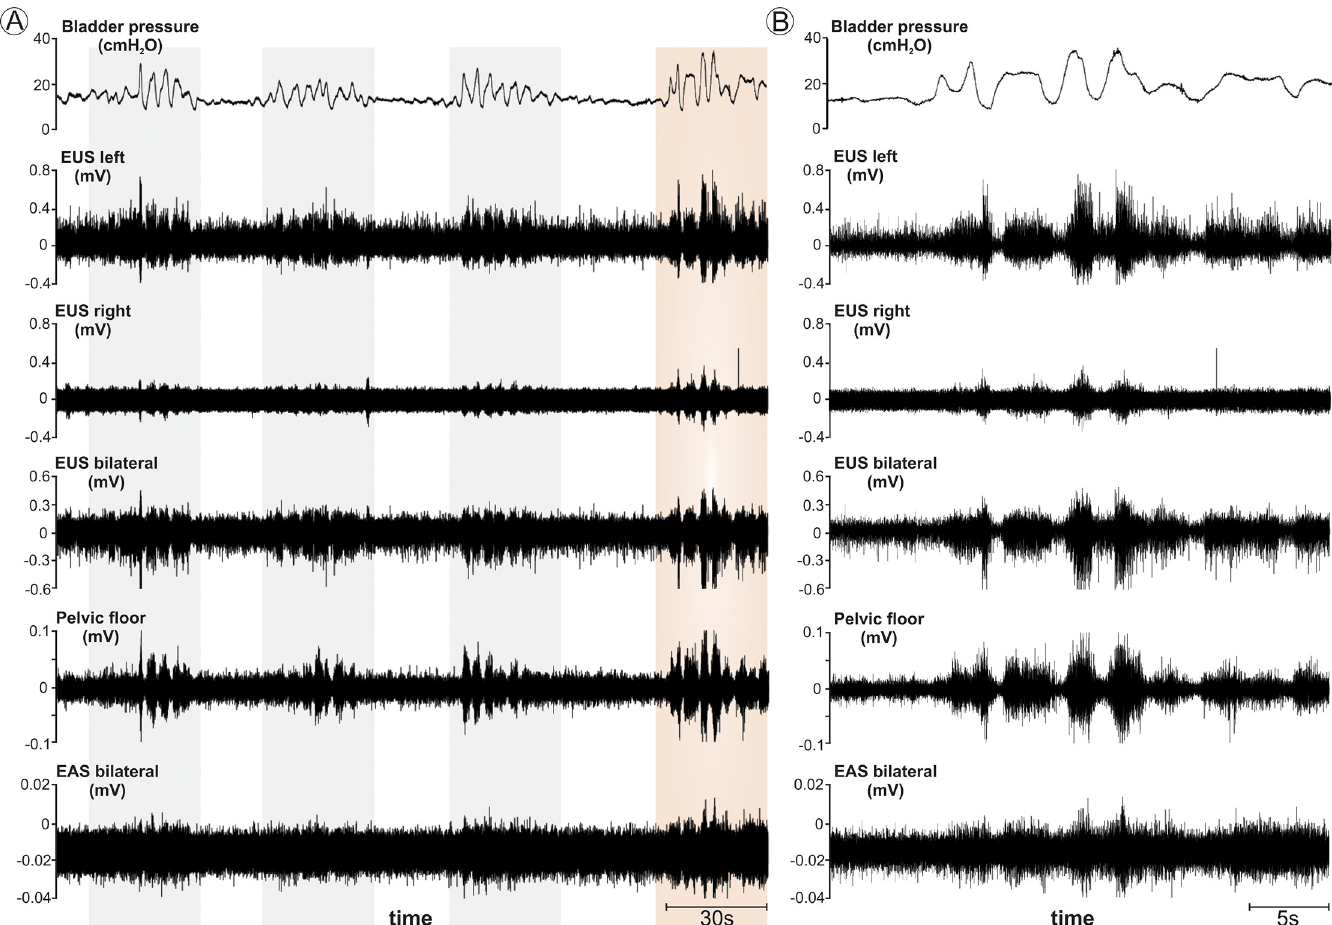
Fig 3. Cystometrogram and electromyography (EMG) from the external urethral and anal sphincters, and pelvic floor in a 30.5 years old rhesus macaque demonstrating generalized tonic muscular reactivity under ketamine anesthesia. A. Prolonged periods of neuromuscular activation with a duration of approximately 30–40 seconds are highlighted and separated by periods of relative quiescence with a duration of approximately 10–20 seconds. Note that the start and end of each period of activity is synchronized across all leads. B. Detail of cystometrogram and EMG recordings from period of activation in colored highlight in A. Note similar patterns of activation across all leads. EUS = external urethral sphincter; EAS = external anal sphincter.